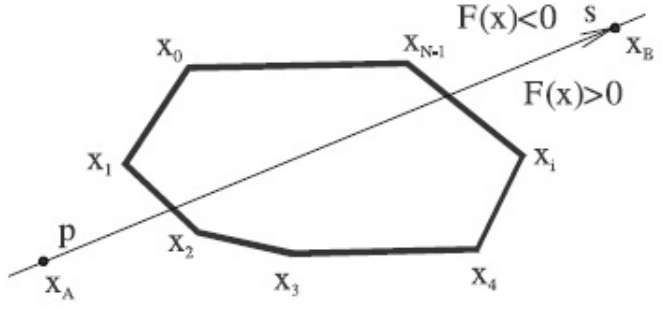
Figure 18. Classification of each vertex.